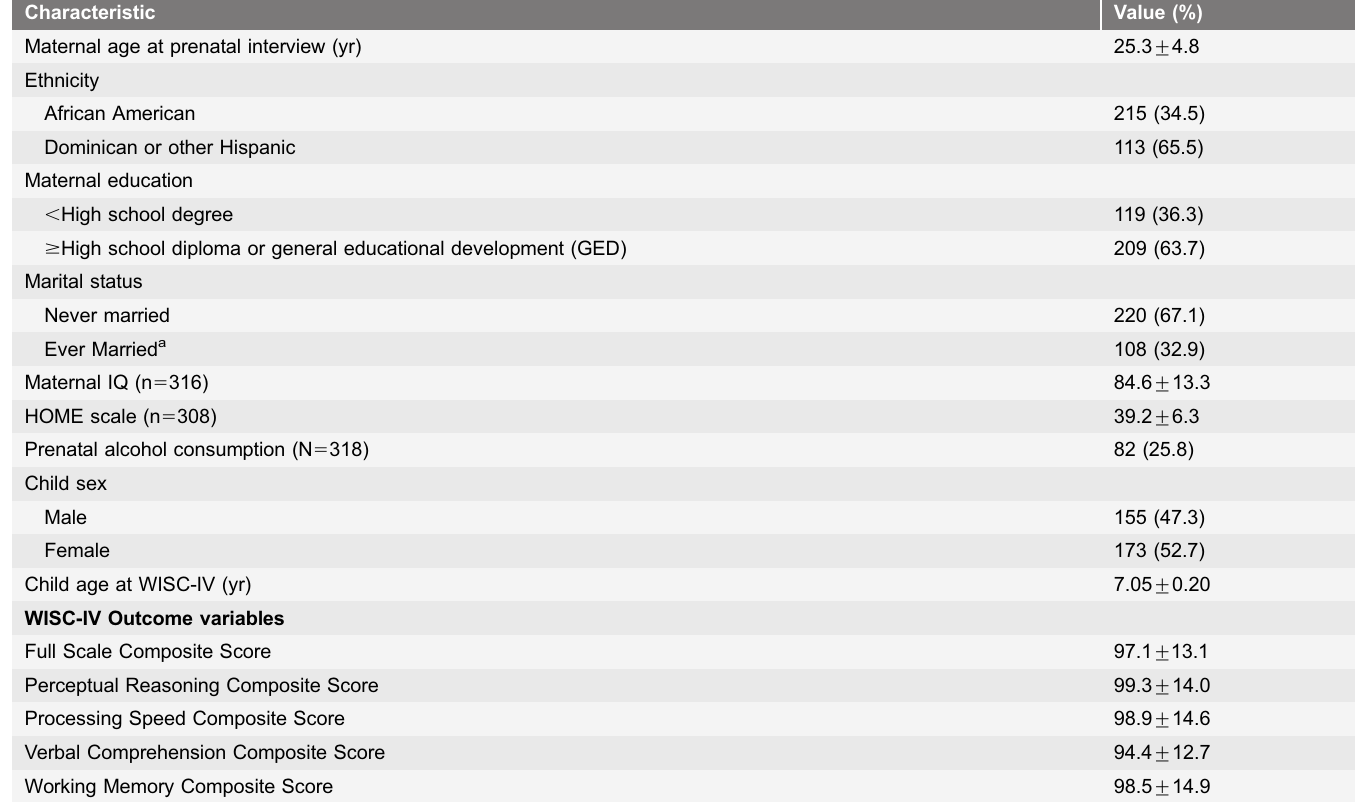
Table 1. Subject demographics, distribution of model covariates, and outcome variables (N 5 328). Characteristic